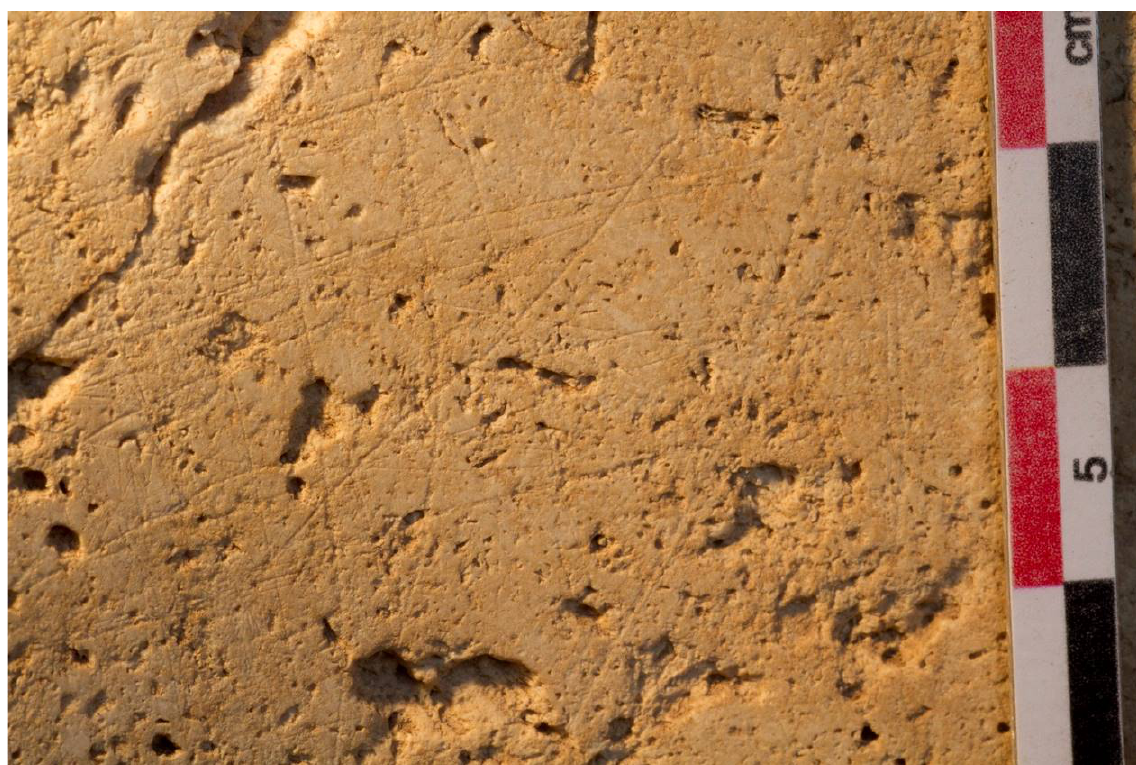
Figure 10. A view of a preserved section with incisions (scale in cm, photograph by E. Bartov).